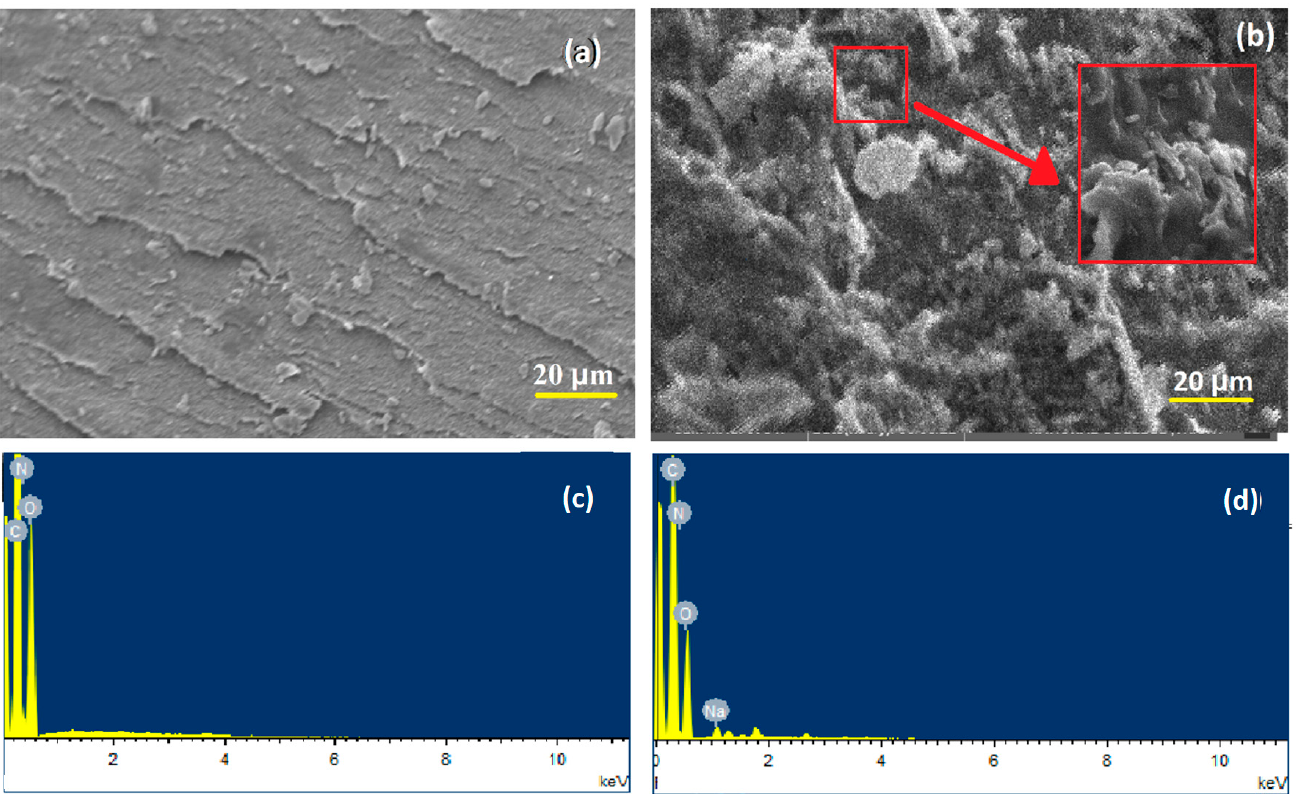
Figure 5. SEM micrographs of ( a ) chitosan and ( b ) CCA, and EDAX spectra of ( c ) chitosan and ( d ) CCA.